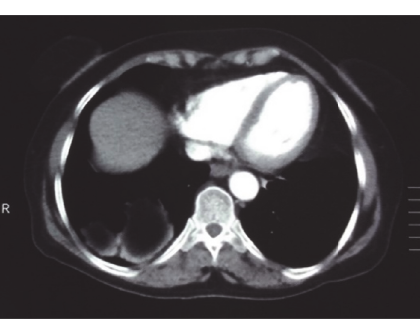
Figure 3: Contrast-enhanced CT scan showed right diaphragmatic